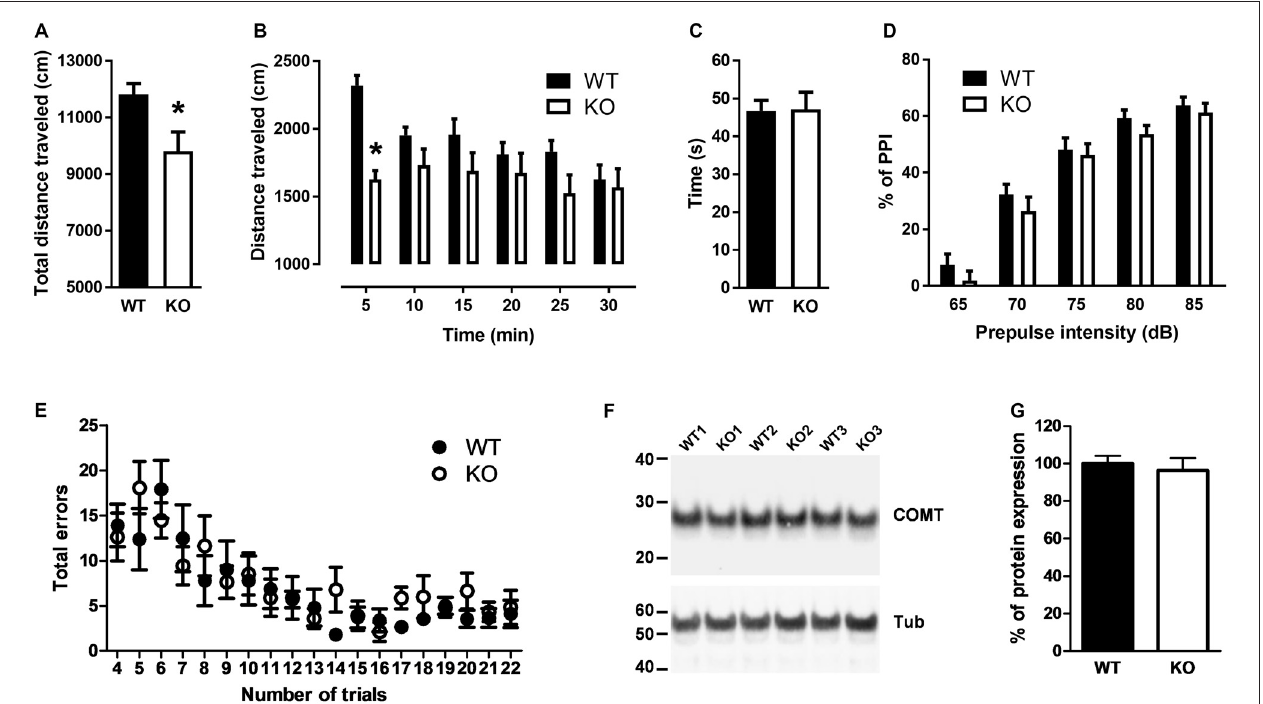
FIGURE 3 | Behavioral analyses of WT and PROT − / − (KO) mice. (A,B) Total distance traveled by WT and KO mice in the open field during a 30 min interval (A) and distance traveled over the 30 min period grouped in six 5-min intervals (B) revealed decreased locomotor activity in PROT-deficient mice ( n = 13 mice for each genotype). (C) Rotarod test on WT and KO mice ( n = 20 mice for each genotype) displayed no significant different performance at the rod. (D) Sensorimotor gating analysis in KO and WT mice assayed by the inhibition of an acoustic startle response (110 dB) with the indicated prepulse dB levels. Pre-pulse inhibition (PPI) (%) values are means ± SEM (WT, n = 24 mice; KO, n = 22 mice; p > 0.05, two-way repeated-measures ANOVA). (E) Performance of KO mice on the eight-arm radial maze displayed no memory deficits over the trial sessions compared to WT animals. Data represent the means ± SEM (WT, n = 10 mice; KO, n = 11 mice) of the number of revisiting errors in each trial. (F,G) Representative immunoblot examining Catechol-O-Methyltransferase (COMT) expression (F) and quantitative analysis of COMT immunoreactive band corrected by β -tubulin (G) of fractions prepared from the cortex of WT and KO mice ( n = 11 mice for each genotype). Data